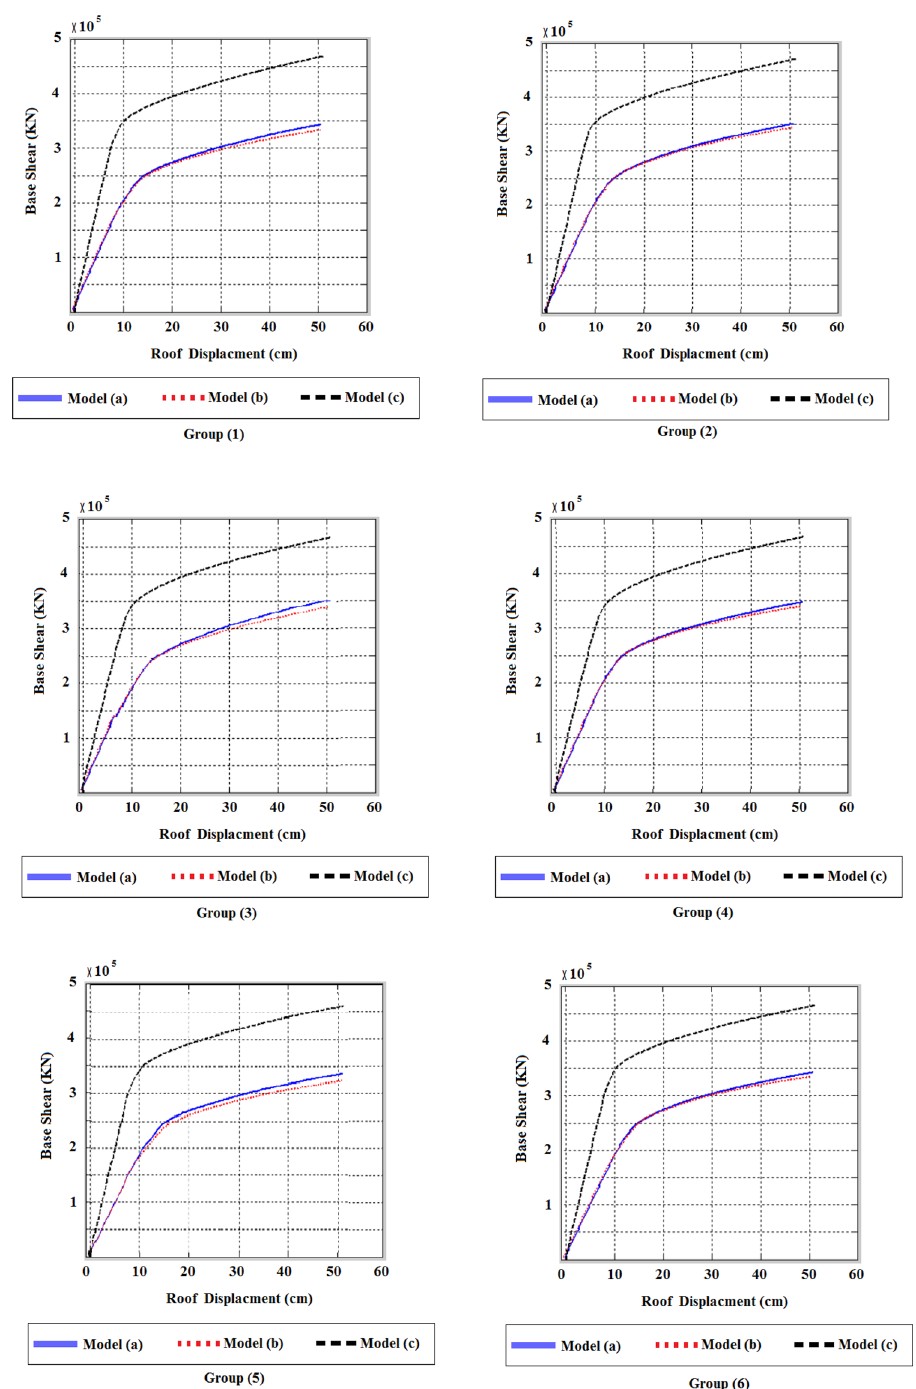
Fig. 10 Pushover curves of different geometric arrange- ments of the 4-story 2-span